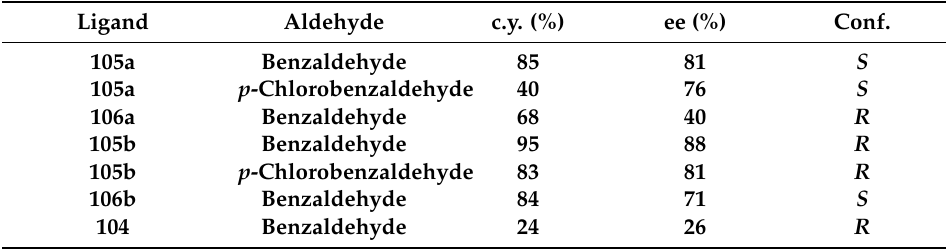
Table 8. Asymmetric addition of diethylzinc to aldehydes catalysed by chiral pyridinyl alcohols [15]. Ligand Aldehyde c.y. (%)